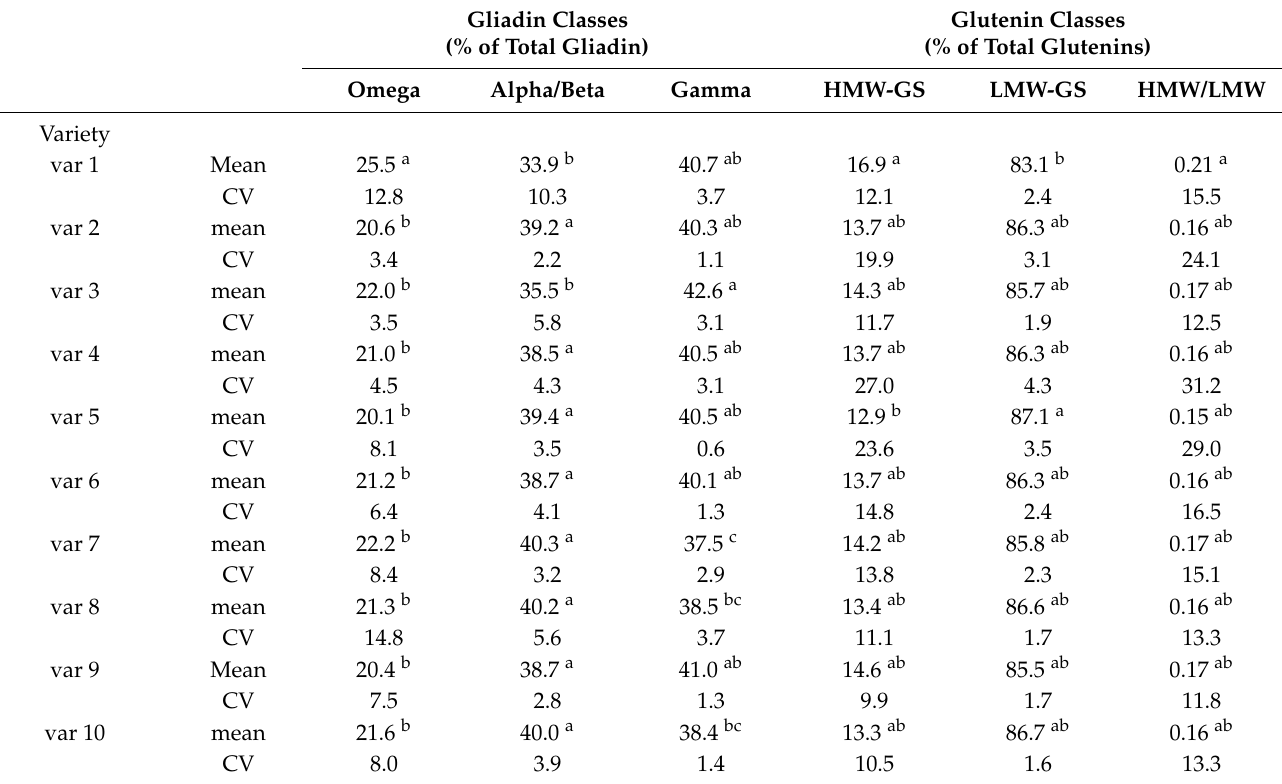
Table 4. Gliadin and glutenin composition of the ten varieties in the three environments. Gliadin